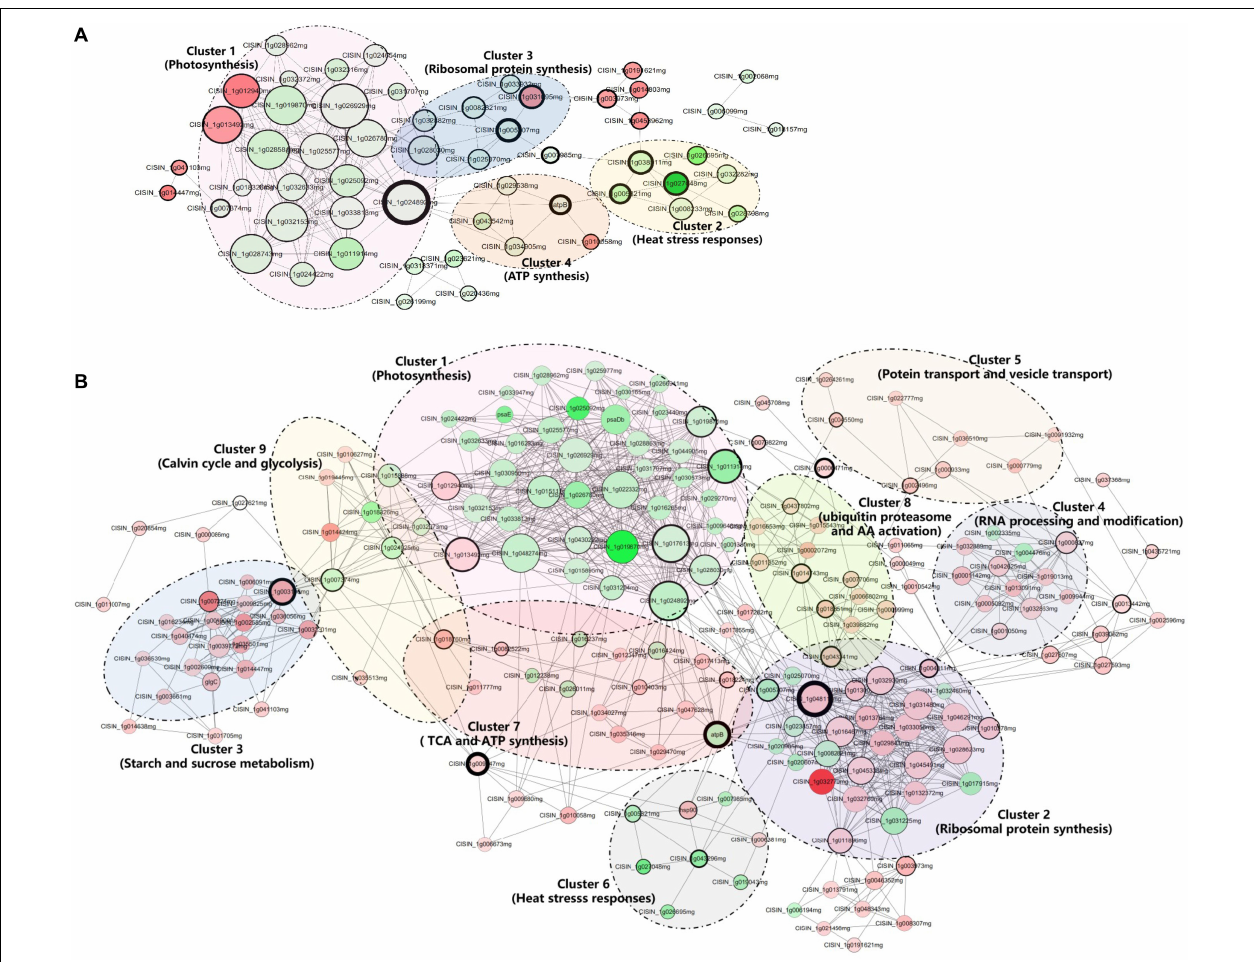
FIGURE 5 | Interaction network of differentially accumulated proteins (DAPs) analyzed by Cytoscape software at the asymptomatic (A) and symptomatic (B) stage. Each cluster is a set of highly connected nodes detected by ClusterONE. The size of the nodes and the width of the black border of nodes are positively correlated to the Degree Centrality and Betweenness Centrality. The upregulated and downregulated proteins in the clusters were shown in red and green, respectively, and the color correlates to the fold change of differentially accumulated proteins. Detailed information on node and a protein list are provided in Supplementary Table 5